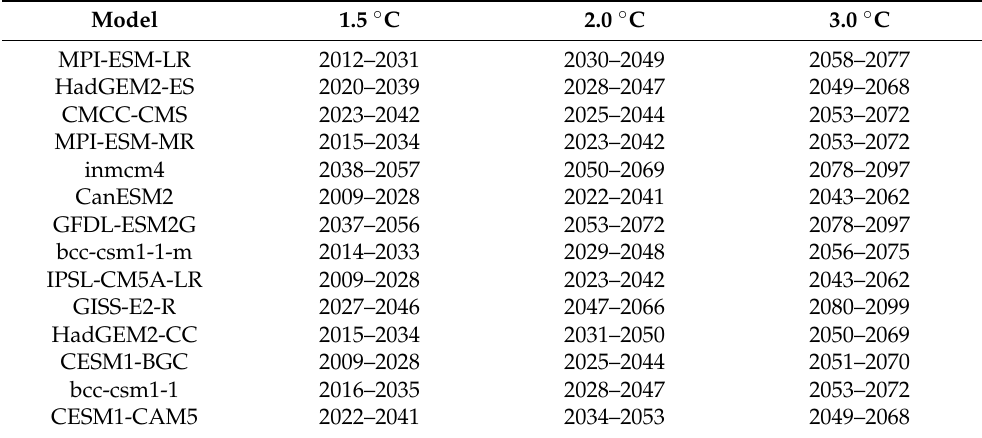
Table 2. Timelines for Global Circulation Models (GCMs) to reach different levels of thresholds of temperature increases in the